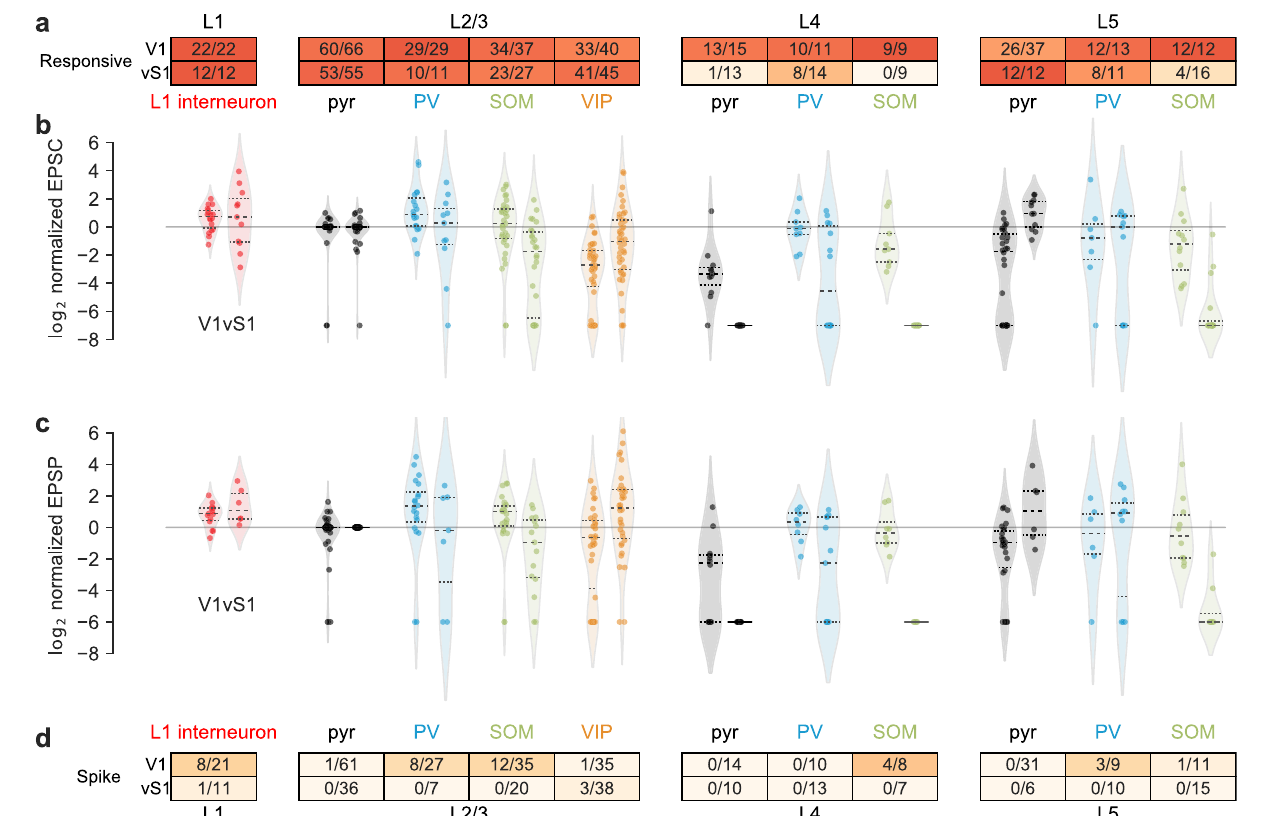
Fig. 3 | Summary ofactivities in V1 and vS1 in response to feedback excitation. a The proportion of responsive cells in V1 or vS1 in different layers (number of responsivecells/totalnumberofrecordedcells).Thecolorinthetableindicatesthe probabilitylevel,sameforpanel( d ). b Thelog2normalizedEPSCofcellsineitherV1 (left) or vS1 (right) normalized to the average EPSC of L2/3 pyramidal cells. Colors andpositionsoftheviolinplotindicatethecelltypecorrespondingtothechartsin